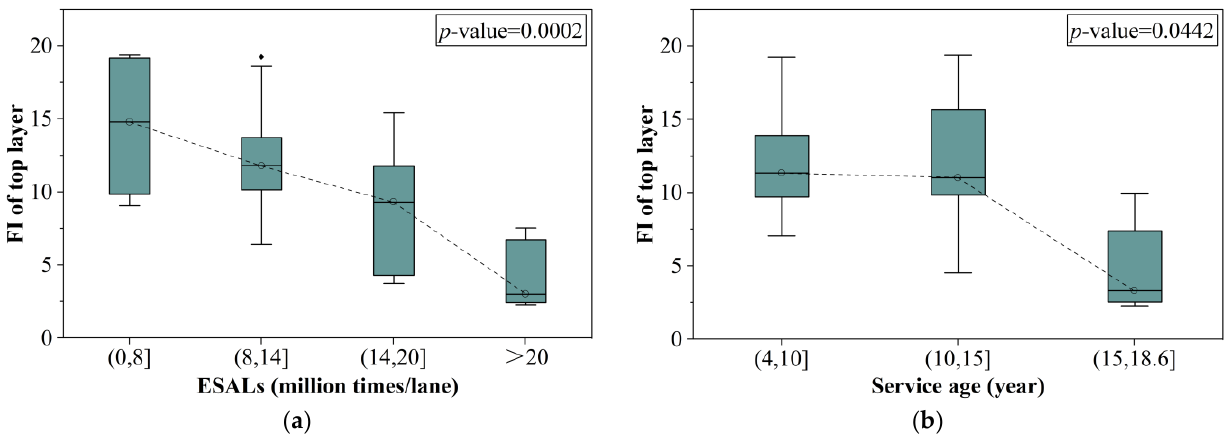
Figure 7. Relationship between FI and significant factors for the top layer: ( a ) FI versus ESALs and ( b ) FI versus service age. ( b ) FI versus service